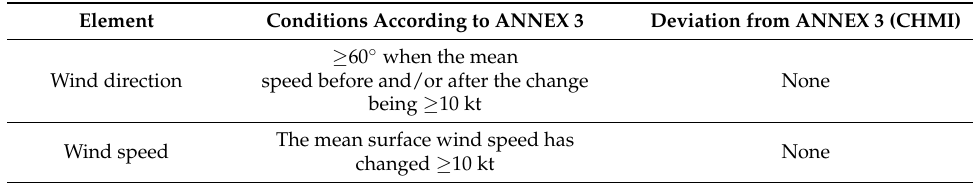
Table 2. Criteria for the issue of Special Meteorological Report (SPECI) according to ANNEX3 App 3-2 (a regulation for Meteorological Service for International Air Navigation issued by the ICAO) with deviations from ANNEX 3 (Czech Hydrometeorological Institute, CHMI). VFR, visual flight rules; SCT, scattered; BKN, broken; OVC, overcast; QNH, value of the atmospheric pressure adjusted to mean sea in an aeronautical code Q code; REG QNH, forecast value of QNH; METAR, Aerodrome Routine Meteorological